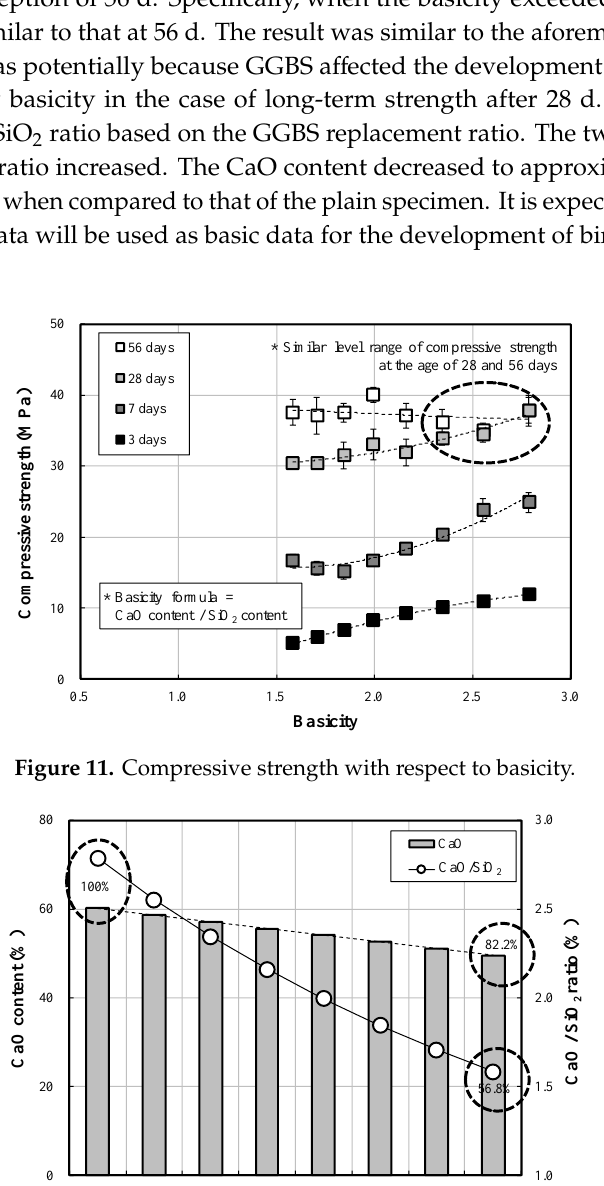
Figure 12. CaO content and CaO/iO 2 ratio with respect to replacement ratio.